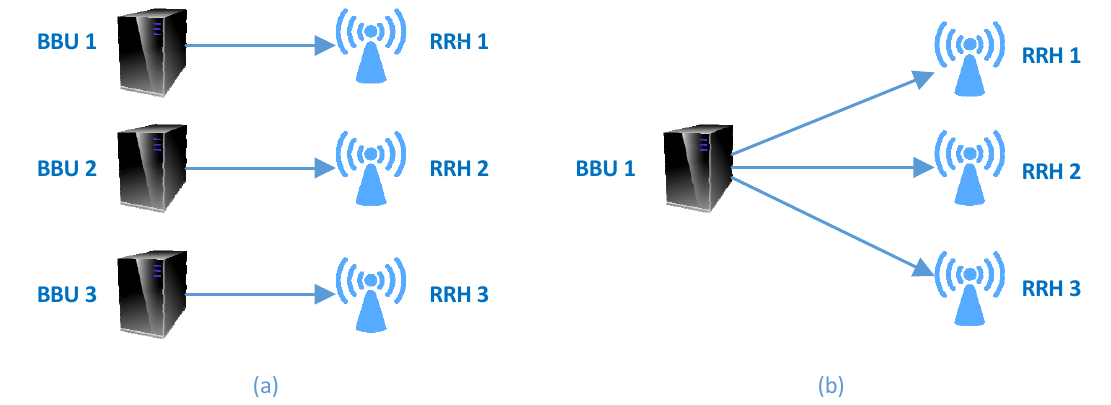
Figure 5. BBU ‐ RRH mapping: ( a ) one ‐ to ‐ one mapping ( b ) one ‐ to ‐ many mapping. Figure 5. BBU-RRH mapping: ( a ) one-to-one mapping ( b ) one-to-many